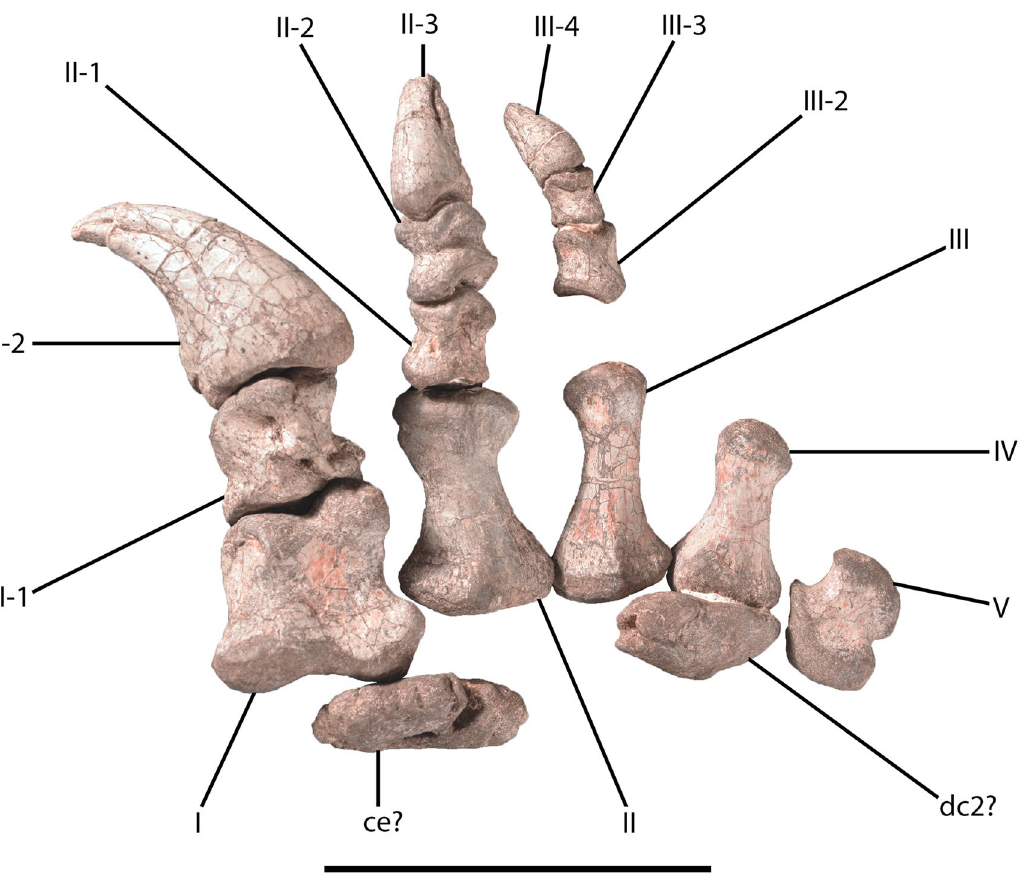
Figure 10. Irisosaurus yimenensis right manus. Abbreviations: ce, centrale; dc2, distal carpal 2; I-V, metacarpals I to V; X-x, digit X phalanx x. Scale bar = 10 cm.